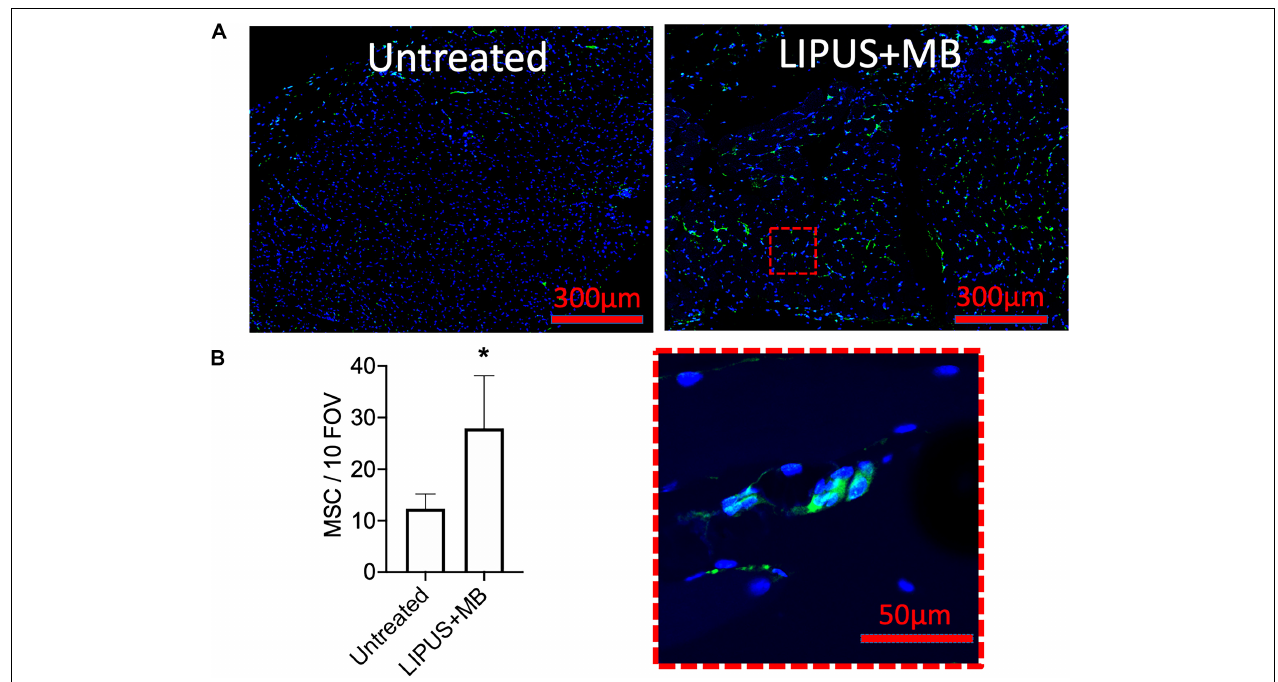
FIGURE 5 | LIPUS + MB increases homing of systemically infused MSC. Mice ( n = 3 per group) received 5 × 10 5 human MSC IV following LIPUS + MB to one hamstring. (A) IHC for human mitochondria revealed increased presence of MSC (green); inset shows high magnification view of MSC) in hamstrings receiving LIPUS + MB compared untreated contralateral hamstring tissue. Quantification in panel (B) counted MSC from 10 high-powered fields-of-view from 3 tissue section per animal (asterisk indicates p < 0.05 by t